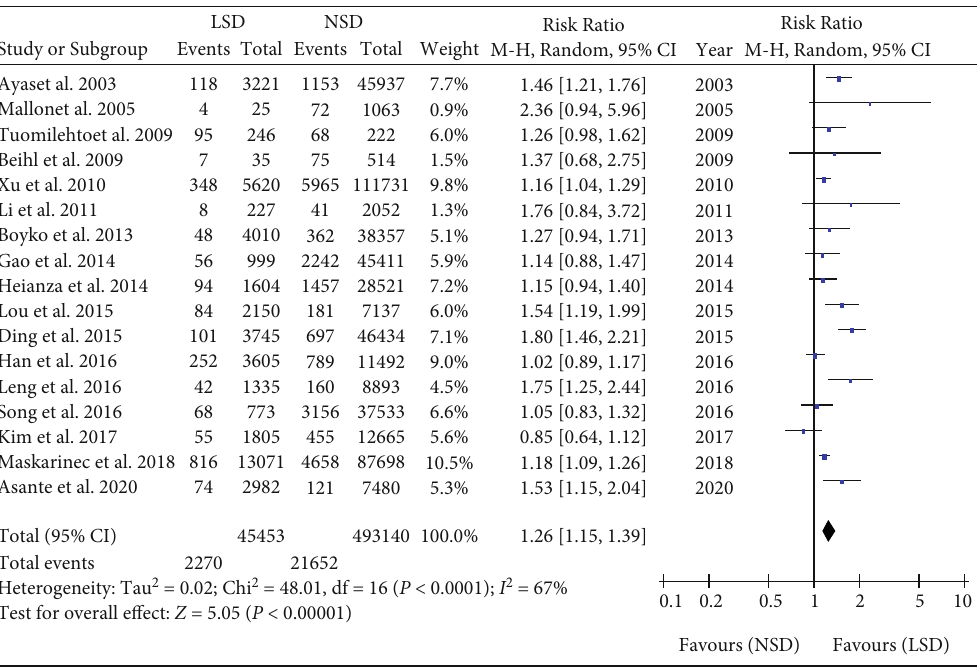
Figure 5: Pooled results for the association between LSD and